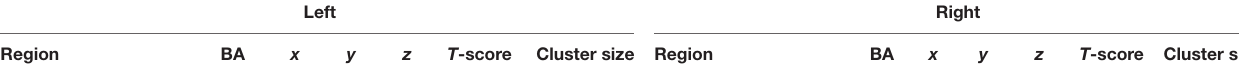
taBLe 2 | Main peak of activation for the [naming treated words before phonological components analysis (PCA) > naming treated words after PCA] contrast and the (naming treated words after PCA > naming treated words before PCA) contrast. Left Right